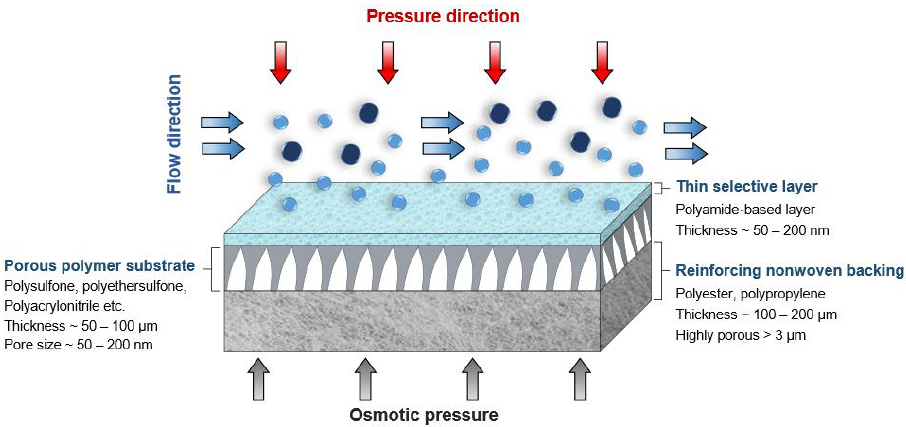
Figure 1. Schematic for the structure of the TFC membranes.